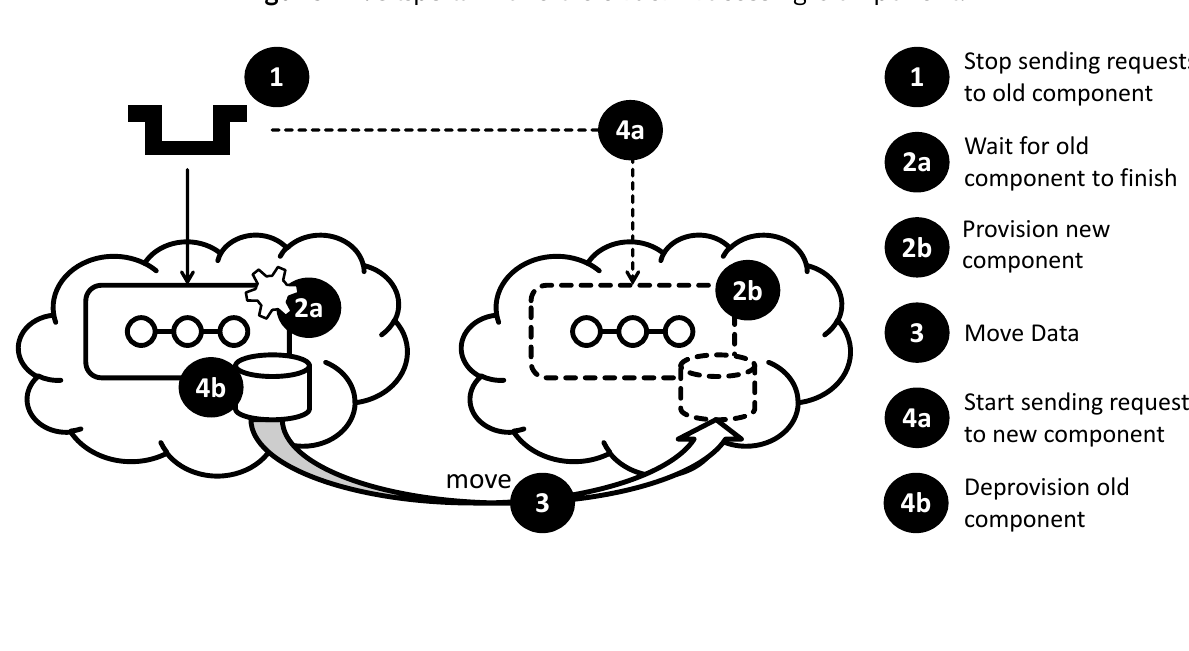
Figure 22. Steps to Move the Order Processing